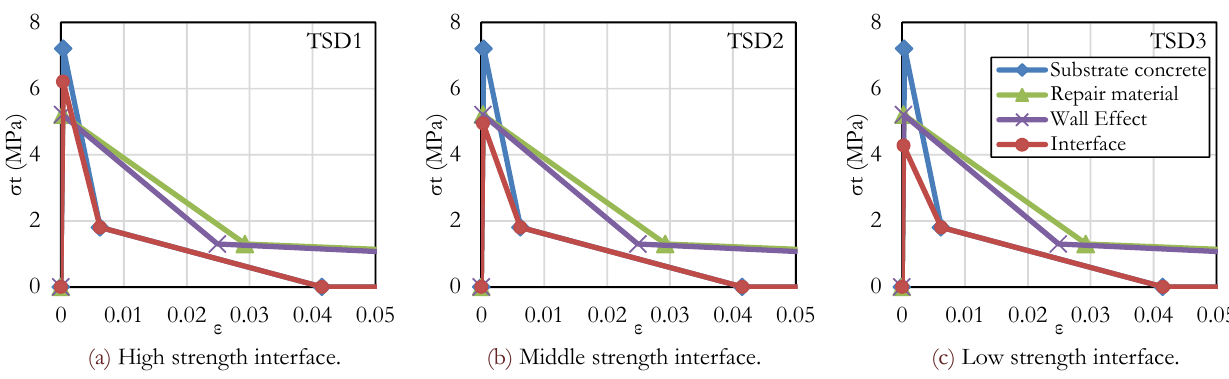
Figure 8: TSDs for matrix element used for FEM analysis.